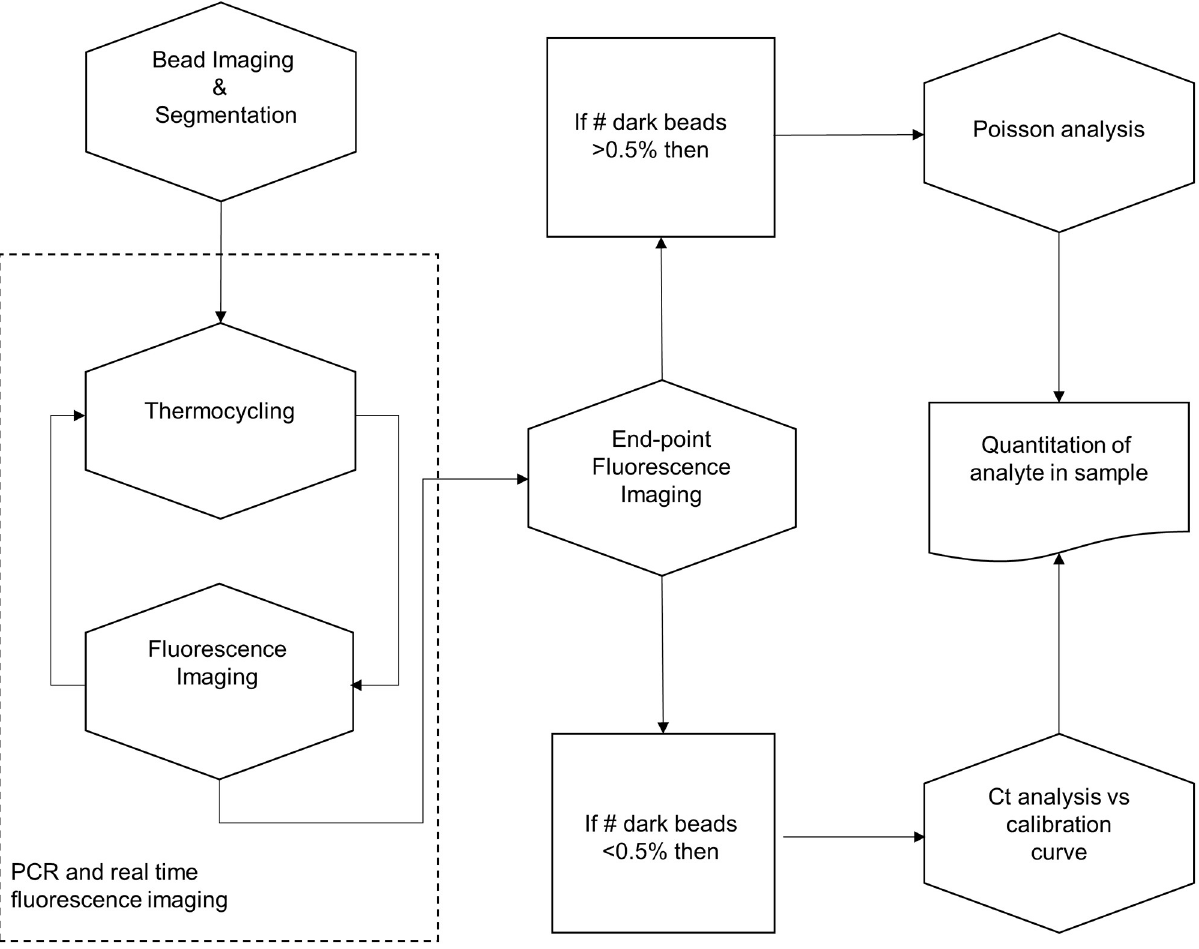
Fig 4. Analysis algorithm for combined digital and real time